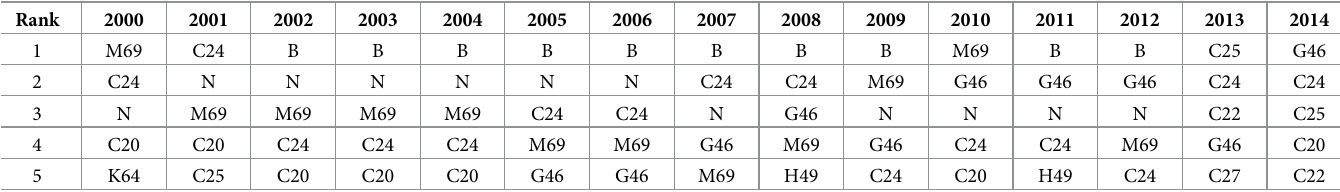
Table 5. Five highest-potential sectors in European community. Rank